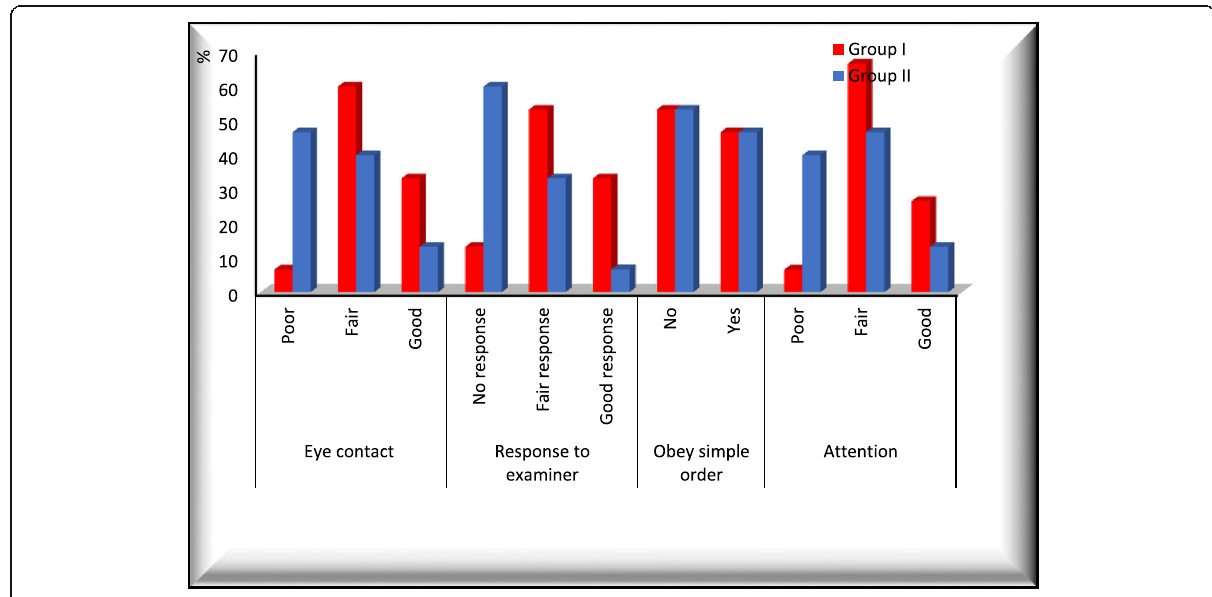
Fig. 2 After treatment clinical evaluation between the two groups